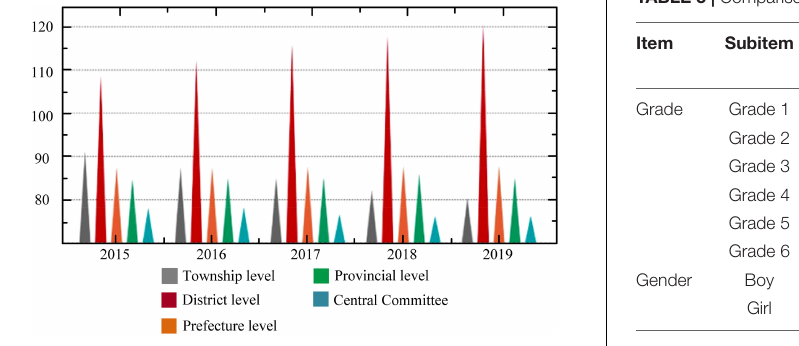
FIGURE 9 | The proportion of government education expenditures at all levels in 2015–2019.